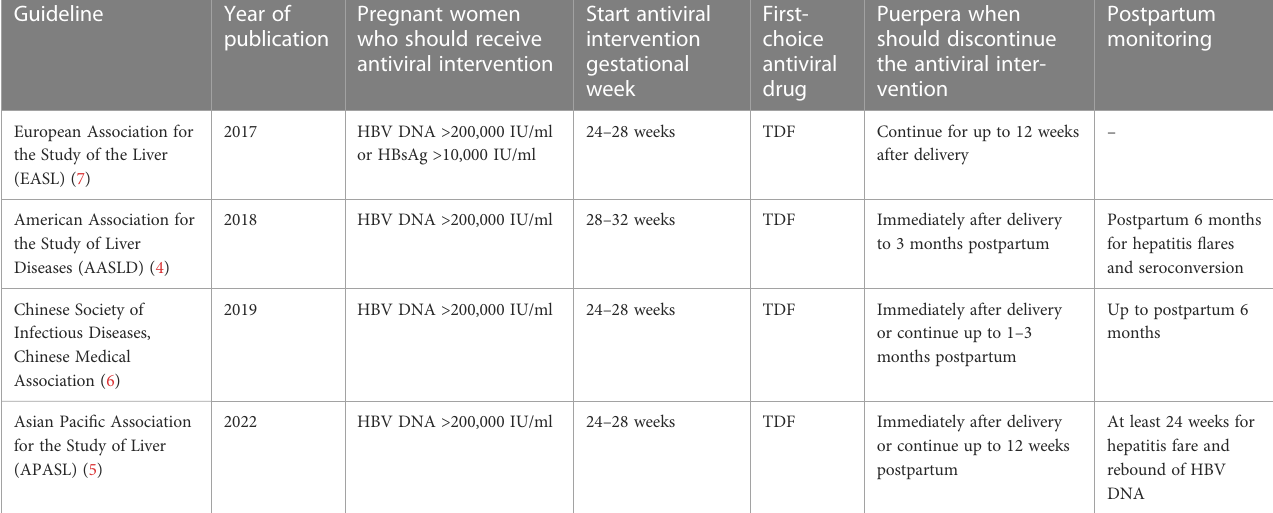
TABLE 1 Guidelines for HBV-infected pregnant women during pregnancy and postpartum.